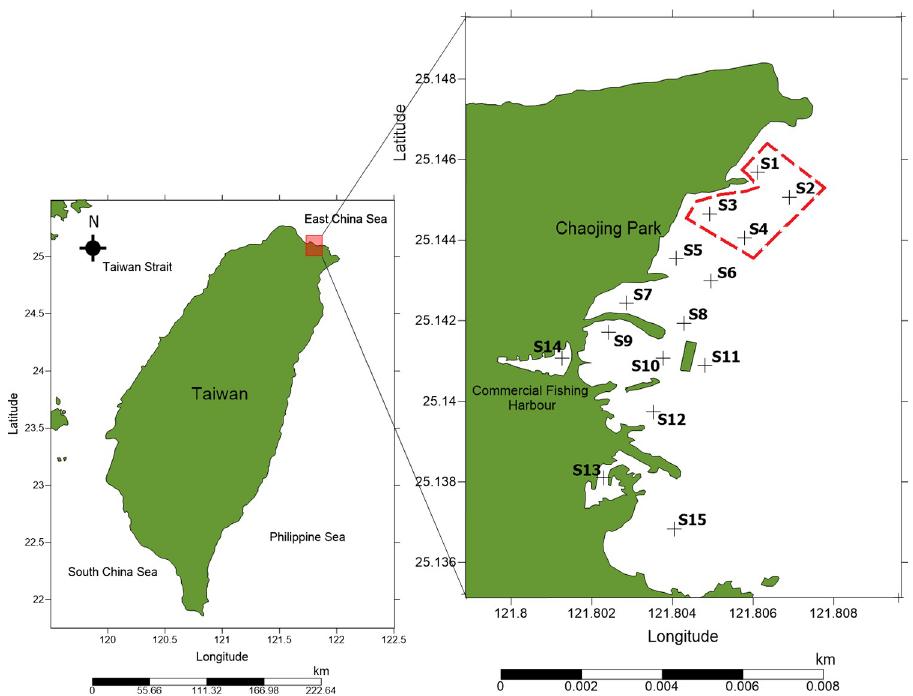
Fig 1. A total of 15 sampling sites with WCJBRA highlighted in red dashed line. Map illustrated by digitizing the base map of OpenStreetMap (under Open Database Lisence). Details refer to www.opendatacommons.org/licenses/